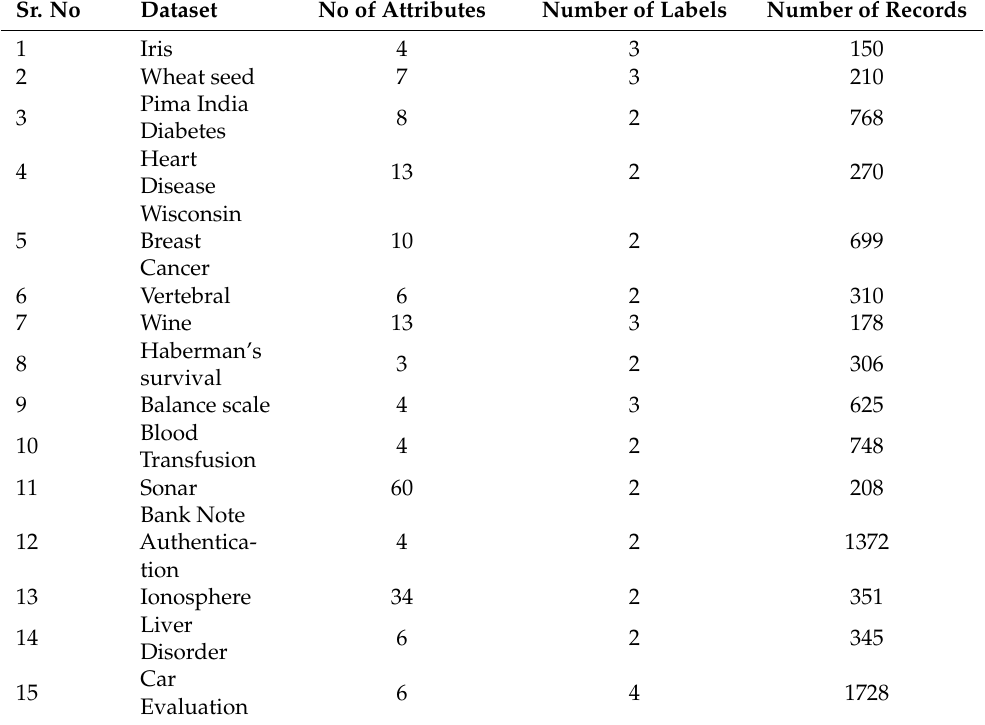
Table 1. Datasets detail.